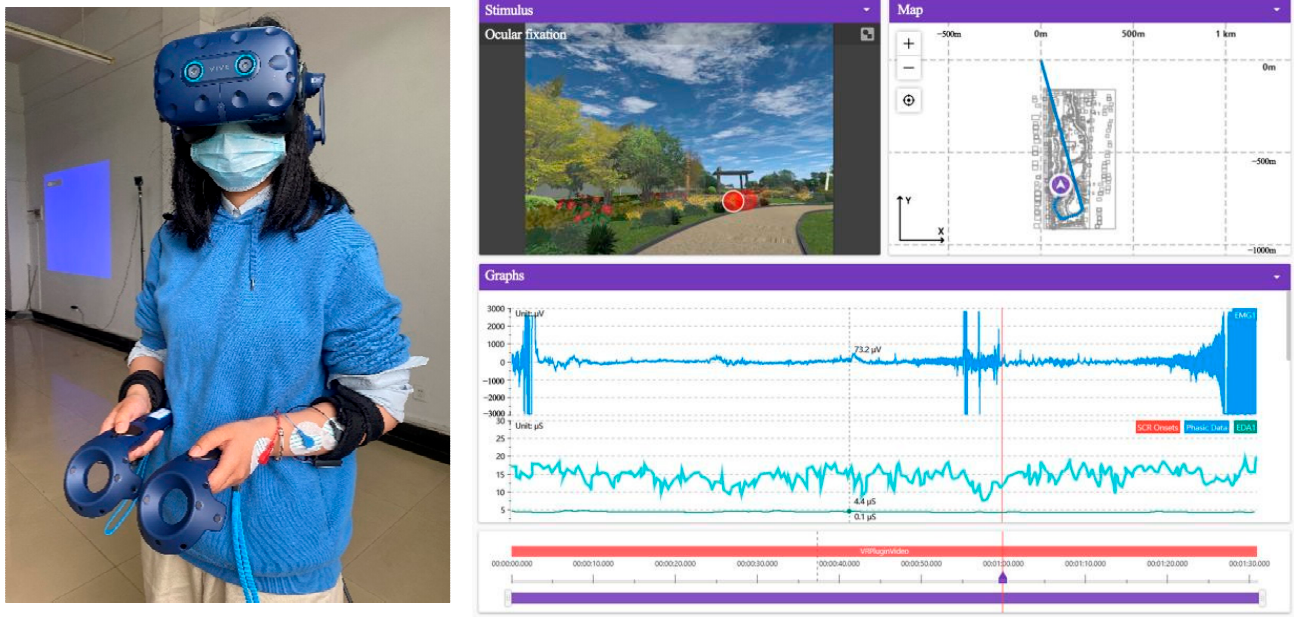
Figure 3. Subjects’ experiment scene and data monitoring interface.